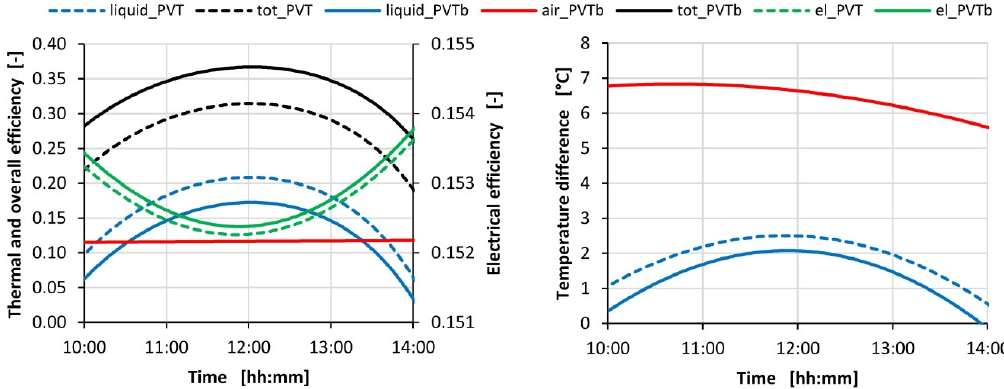
Figure 8. Comparison between the PVT and PVTb performances during a winter day.